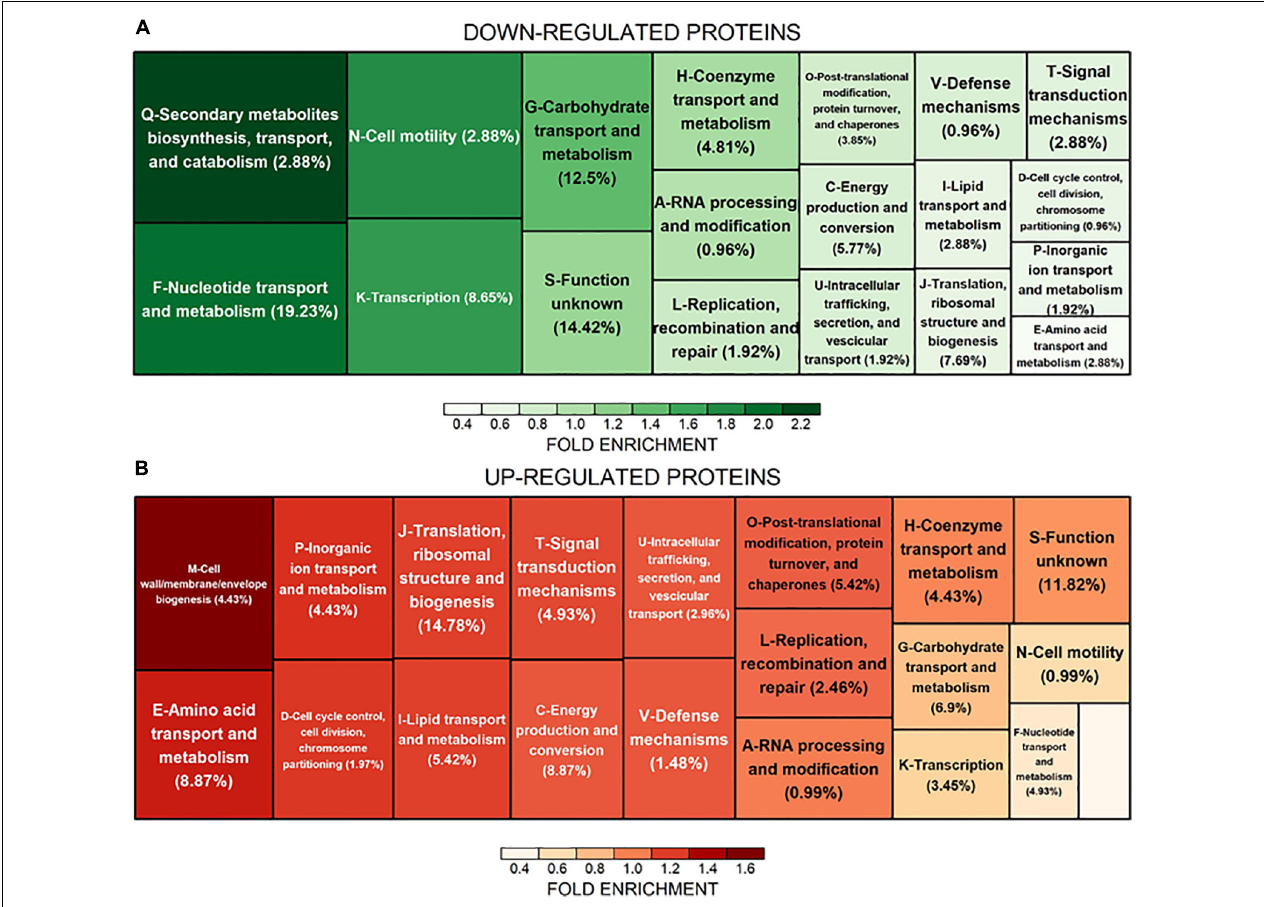
FIGURE 4 | COG categories overrepresentation in differentially expressed proteins. The treemap displays the fold enrichment of each COG category in (A) down-regulated and (B) up-regulated proteins. The size and color of the rectangles are proportional to the registered fold enrichment. The proportion of regulated proteins that are annotated to each COG category is shown in